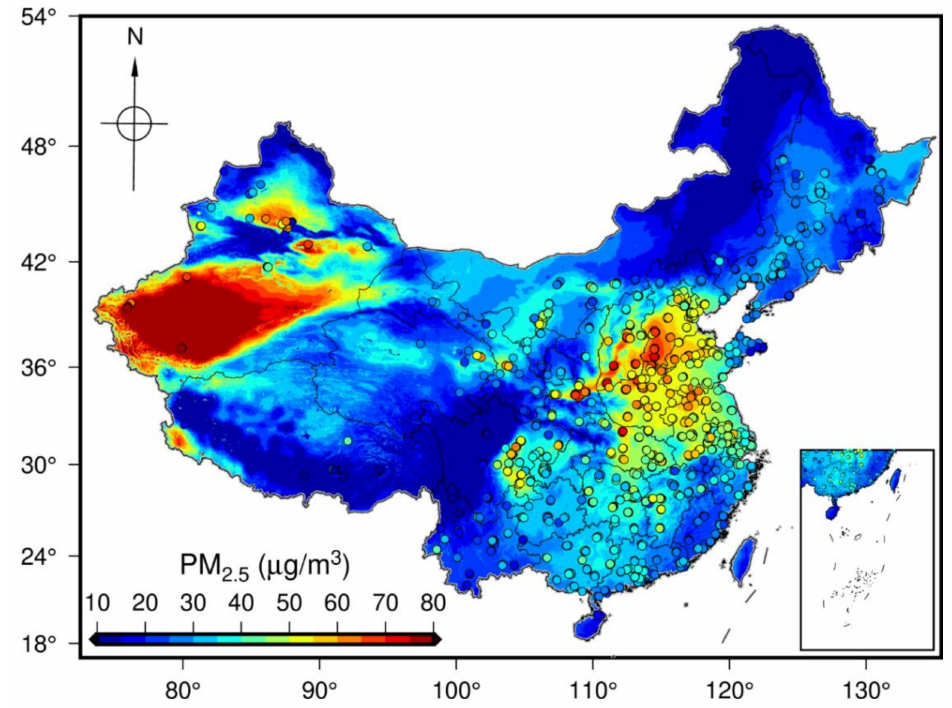
Figure 5. Spatial mappings of annual mean ground-measured and satellite-estimated PM 2.5 concen- trations in